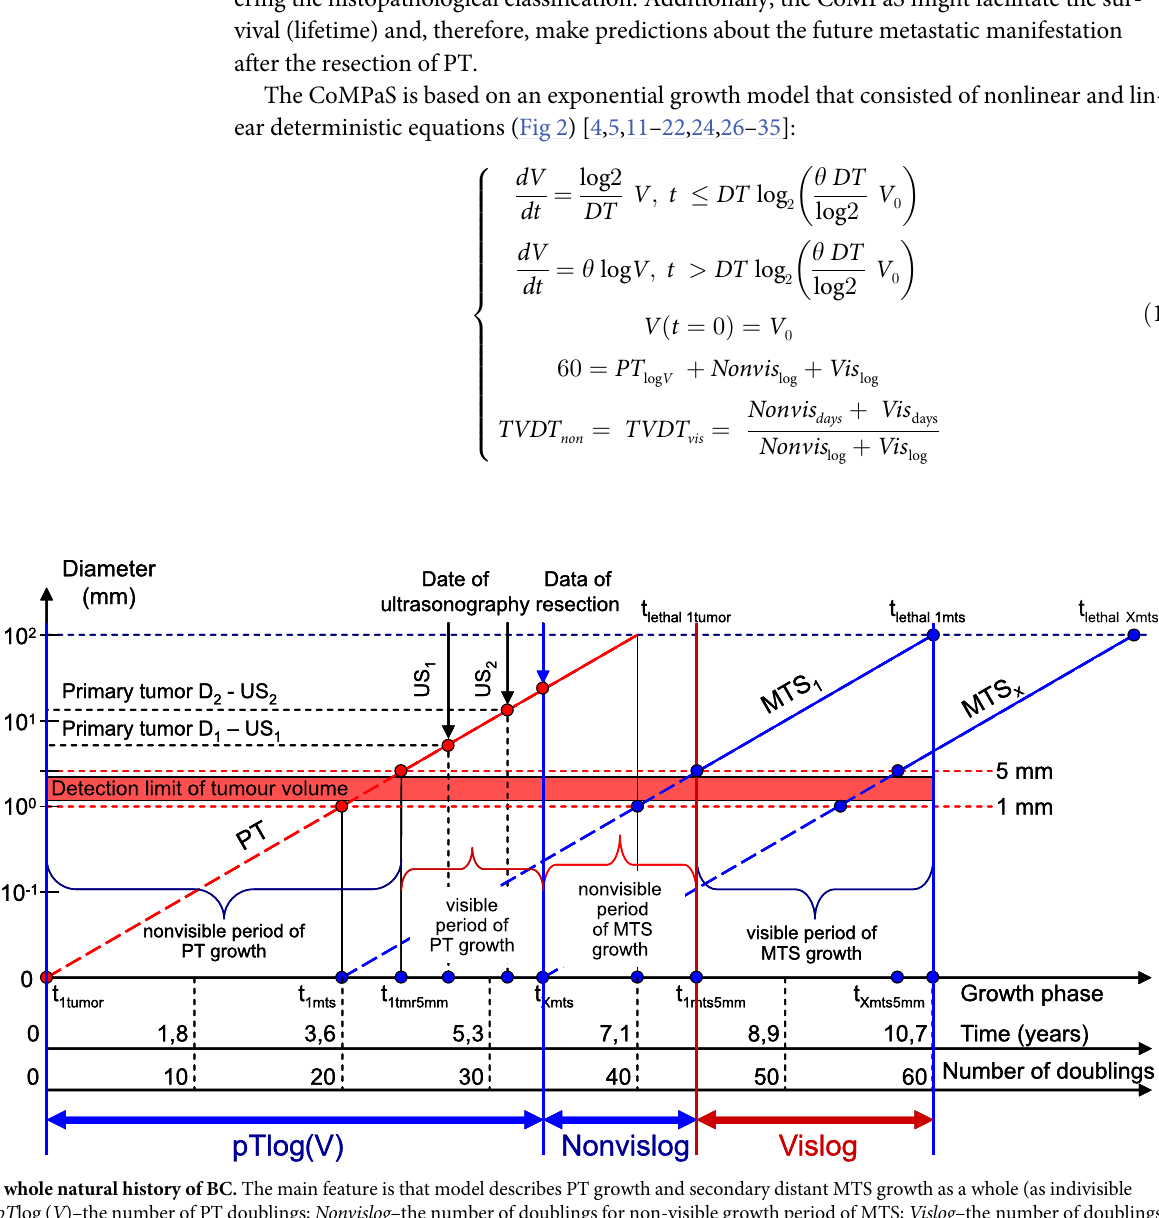
PLOS ONE | https://doi.org/10.1371/journal.pone.0200148 July 6,